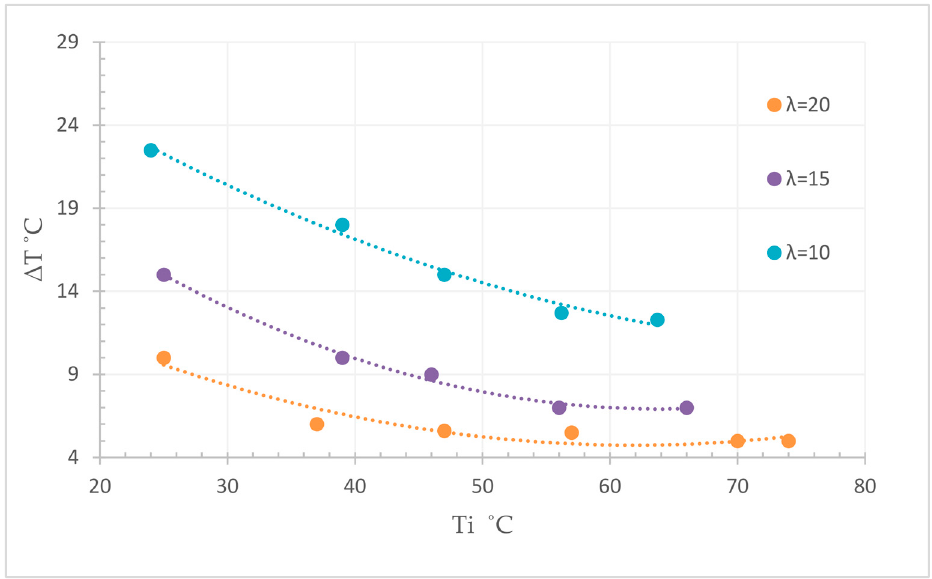
Figure 15. Total temperature rise of the hydration reaction as a function of water surplus λ (20, 15, and 10) and initial temperature T i [35].